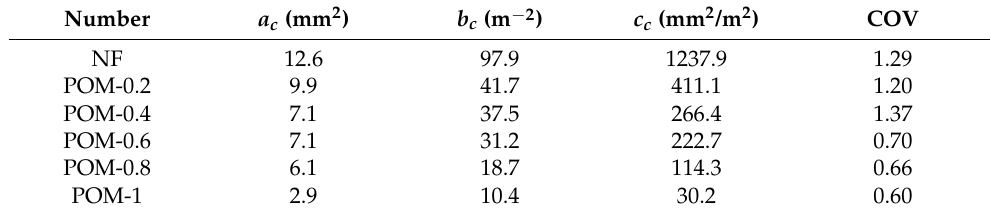
Table 7. Test results of early-age cracking performance.